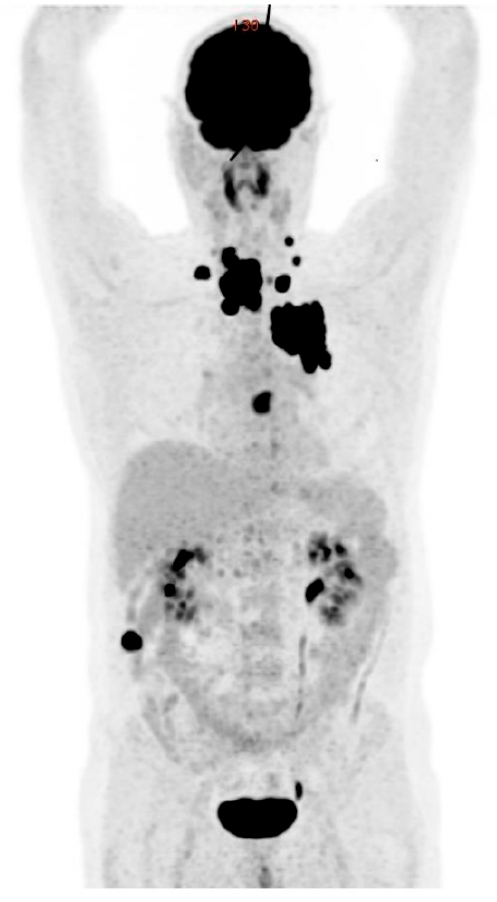
Figure 6. [ 18 F]FDG-PET/CT: anaplastic thyroid cancer with diffuse loco-regional invasion, lymph node, and distant metastases (lung, heart, and bone).